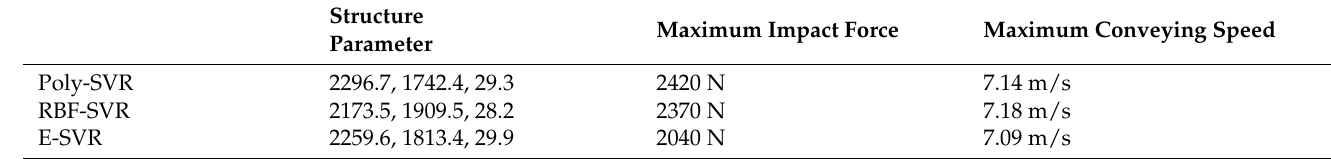
Table 8. Comparison results of single/ensemble-kernel SVR